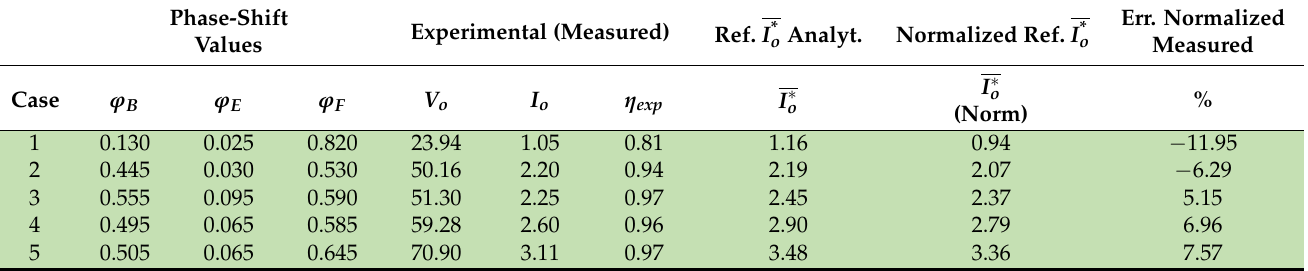
Table 5. Optimized open loop control at 100 kHz.